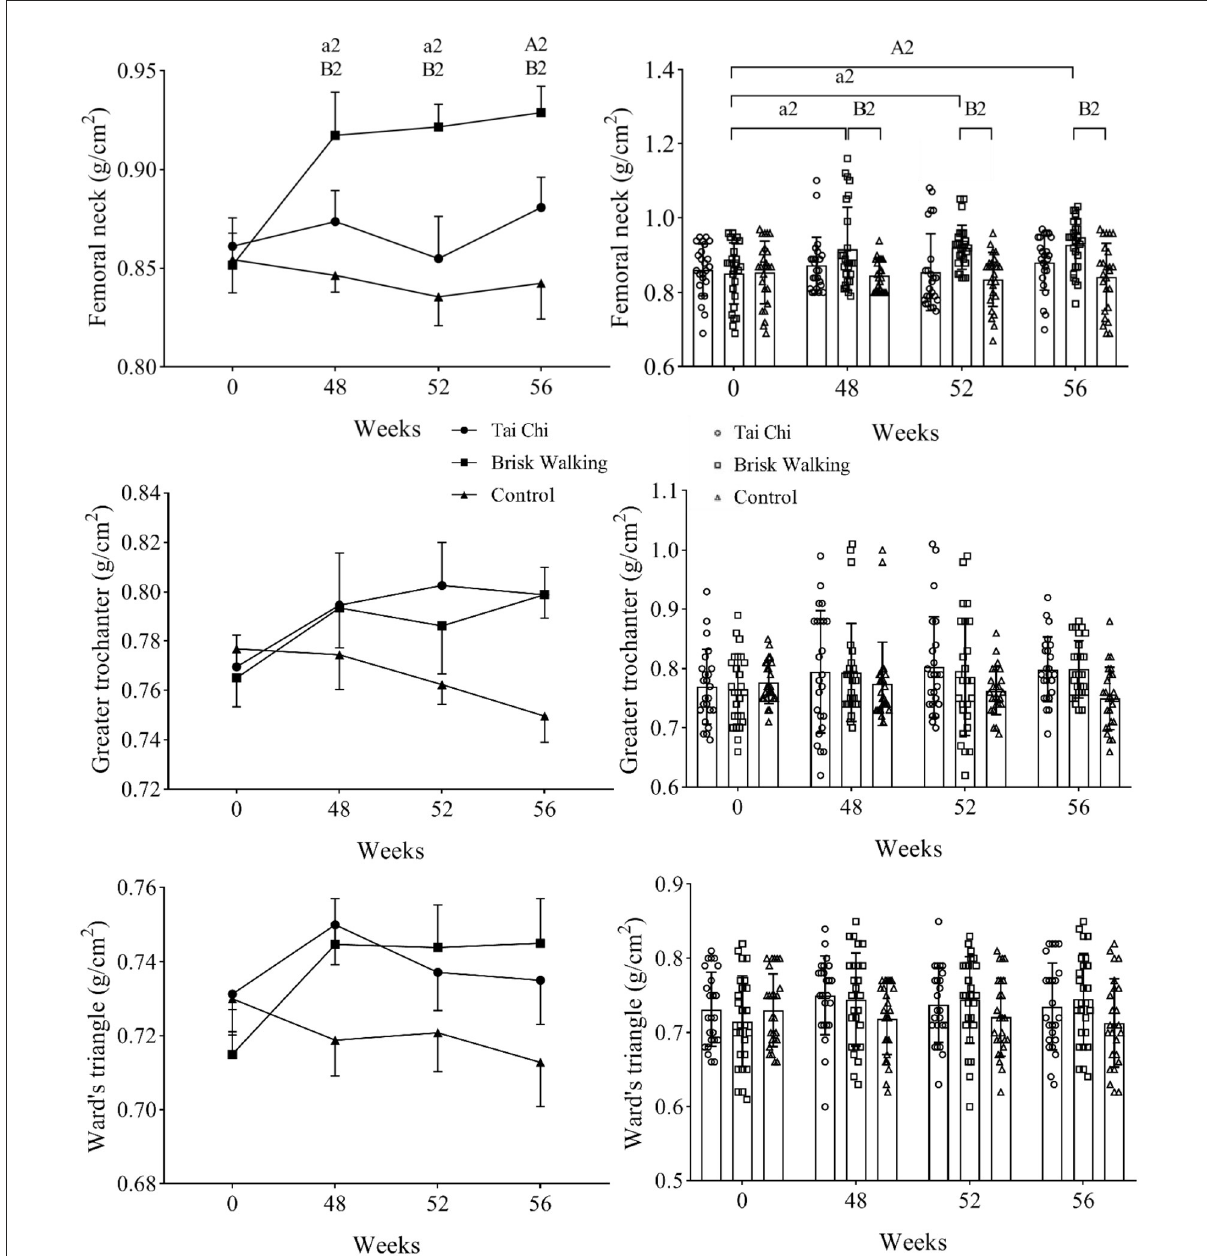
FIGURE3 Bone mineral density of the proximal femur. Fifty-two weeks is 4 weeks after exercise cessation, and 56 weeks is 8 weeks after exercise cessation. Brisk Walking group intra-group comparison, in the comparisons of week 48, week 52, week 56 vs. week 0, a2 indicate differences of P < 0.05, while A2 indicate differences of P < 0.01. Brisk Walking group compared with the control group at the same timepoint, B2 indicate differences of P <